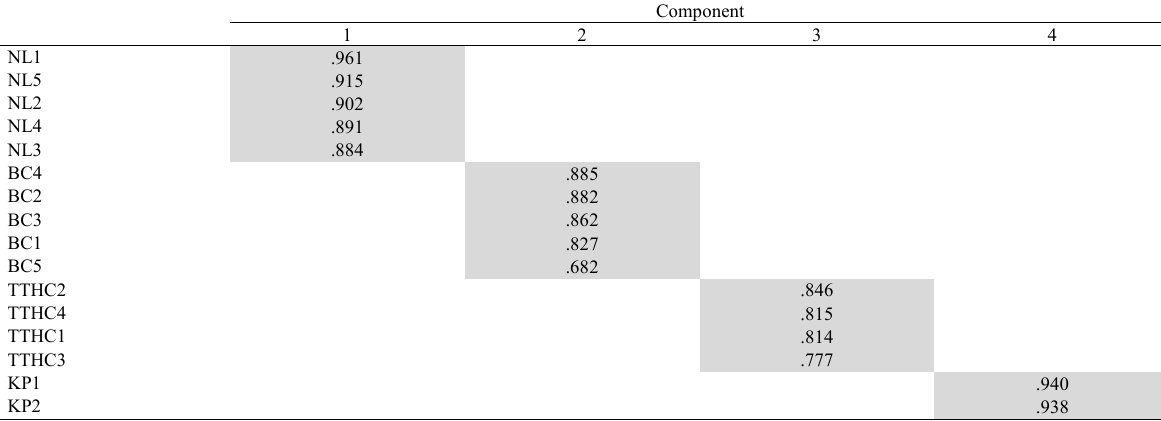
Factor rotation matrix